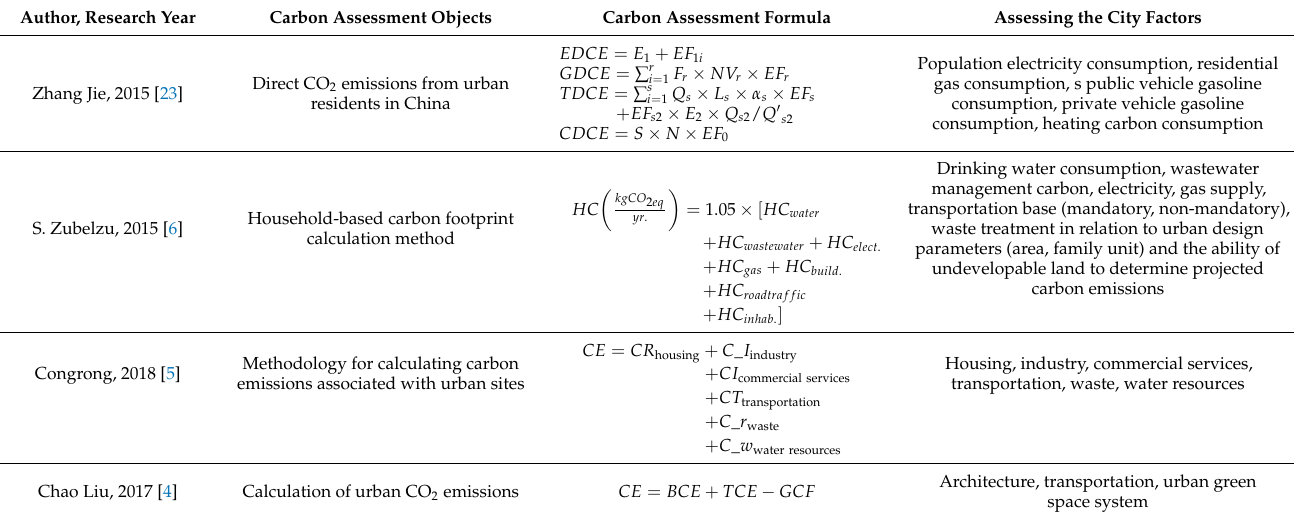
Table 1. Summary of urban carbon emission calculation